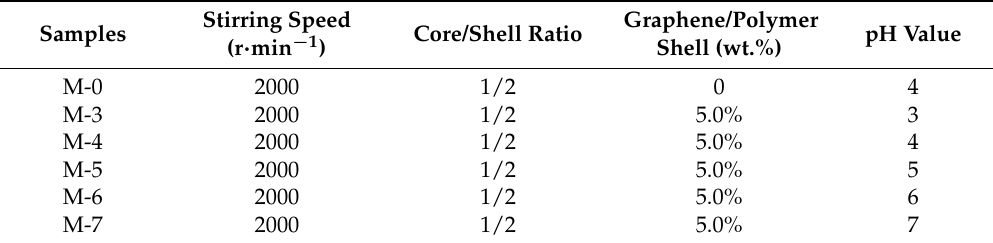
Table 1. The microcapsule samples prepared with various